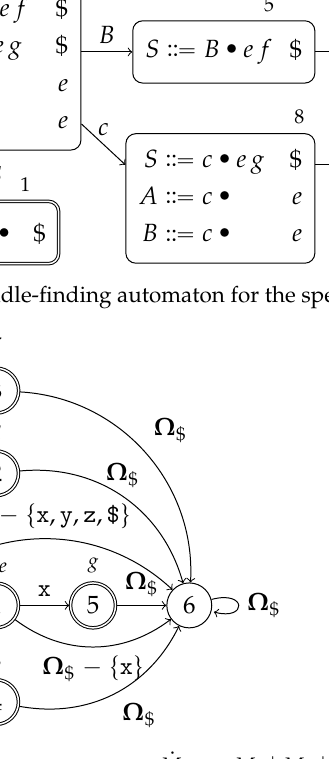
Figure 6. The scanner automaton 9 M T